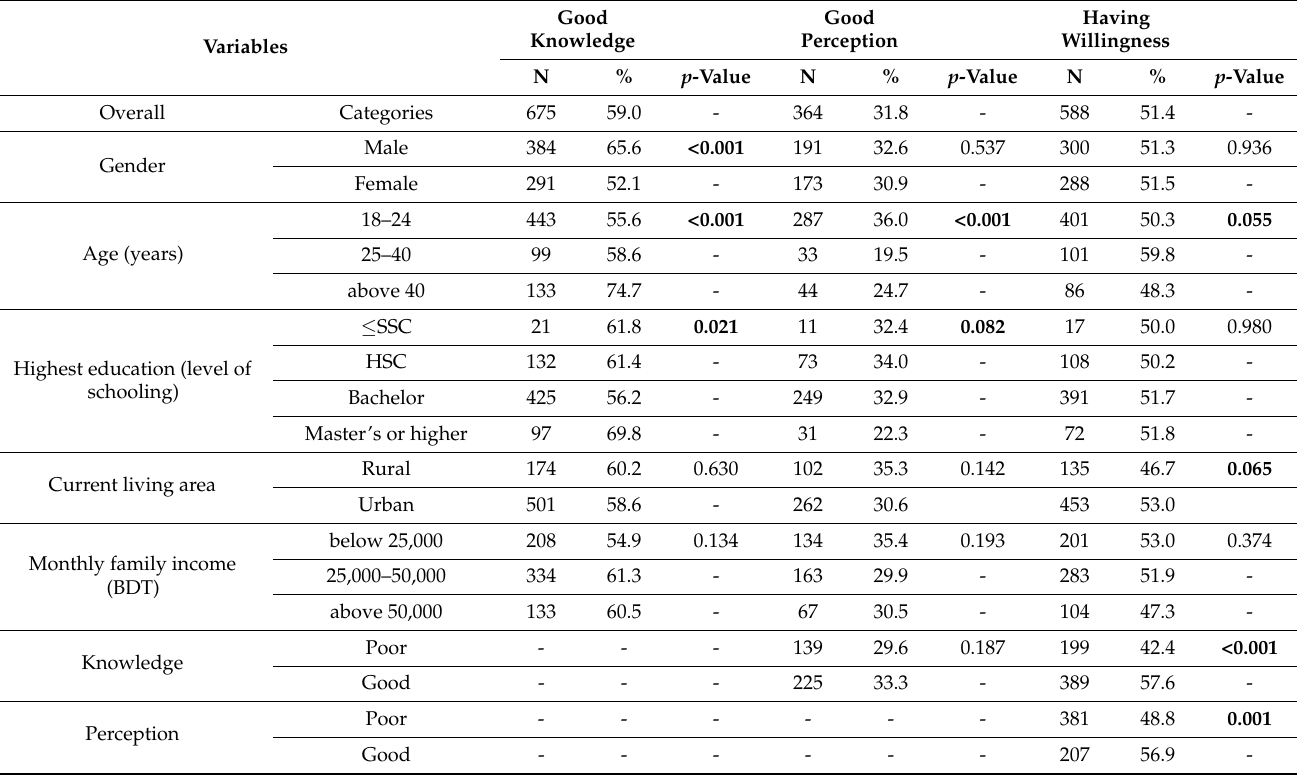
Table 2. Chi-square ( χ 2 ) test of demographic and socio-economic characteristics of Bangladeshi population who have good knowledge, good perception, and willingness of getting